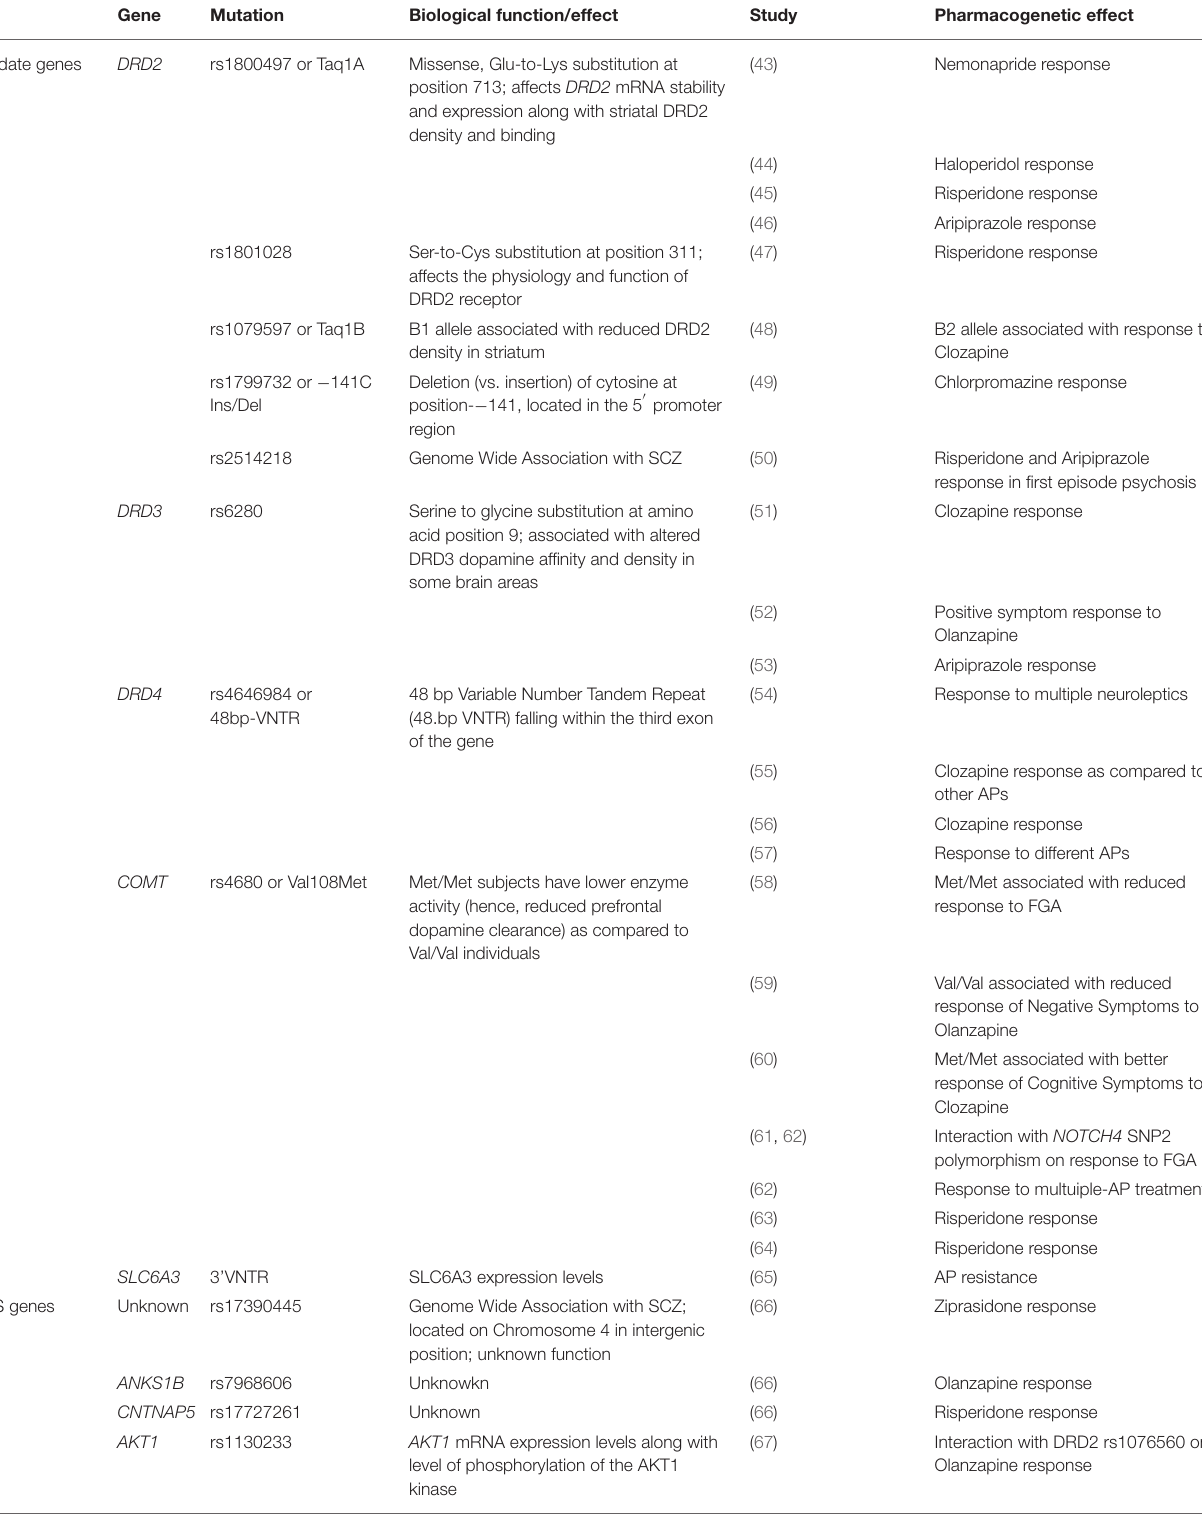
TABLE 2 | Genes and corresponding mutation implicated in antipsychotic response/resistance by Candidate gene studies or